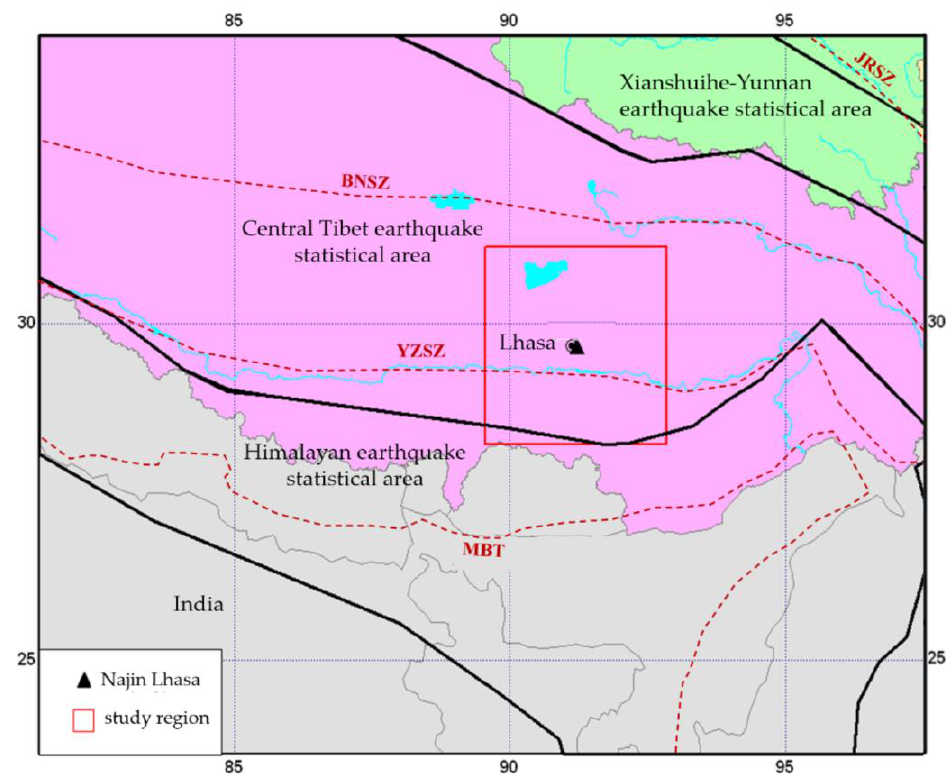
Figure 1. Tectonic map. The red rectangular indicates the study area. The background colored in pink indicates the Tibet autonomous region, and the green part indicates the Qinghai province, China. Black lines indicate the boundaries of the earthquake statistical area. The dashed red lines indicate the main faults and terrain boundaries. YZSZ: Yarlung–Zangpo suture zone; BNSZ: Bangong–Nujiang suture zone; JRSZ: Jinsha River suture zone; MBT: Main Boundary Thrust.